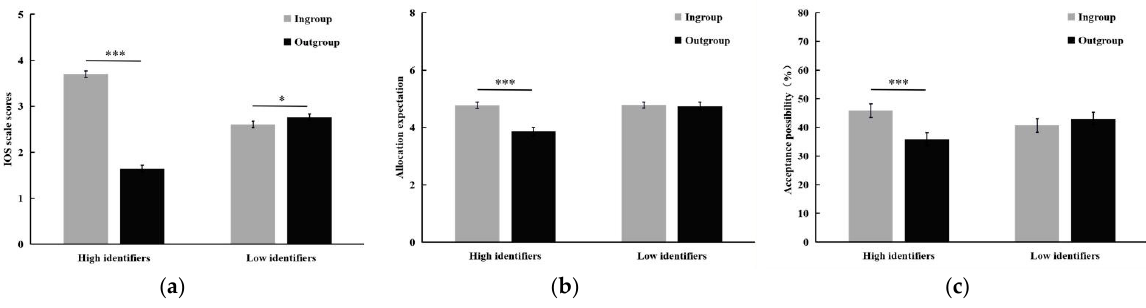
Figure 2. Results from Study 2. Averaged ( a ) IOS scale scores, ( b ) allocation expectation and ( c ) acceptance possibility as a function of group affiliation, separately for the high and low identifiers. Error bars indicate standard error. * p < 0.05, *** p <